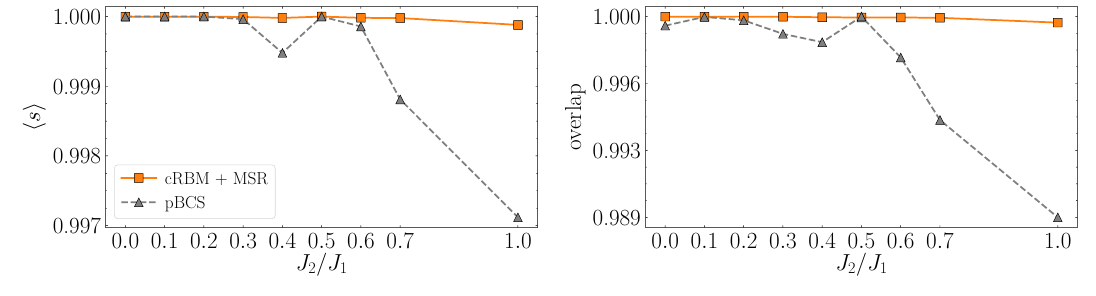
| Ψ 〉| for the best-energy cRBM Ansatz 0 cRBM / J . The results of the pBCS state 2 1